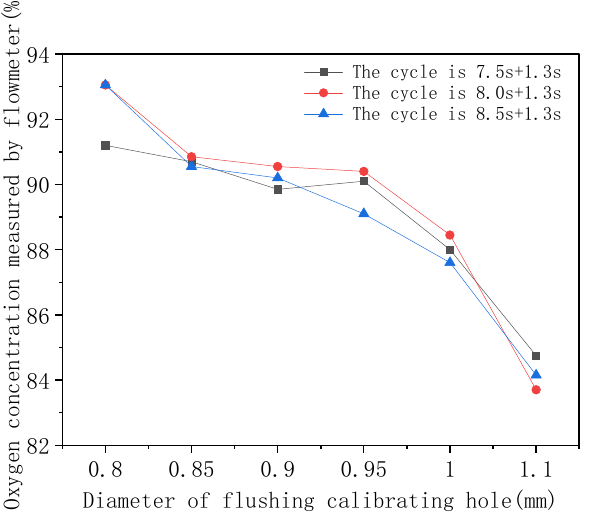
Figure 7. Variation of outlet oxygen concentration in different cycle configurations.